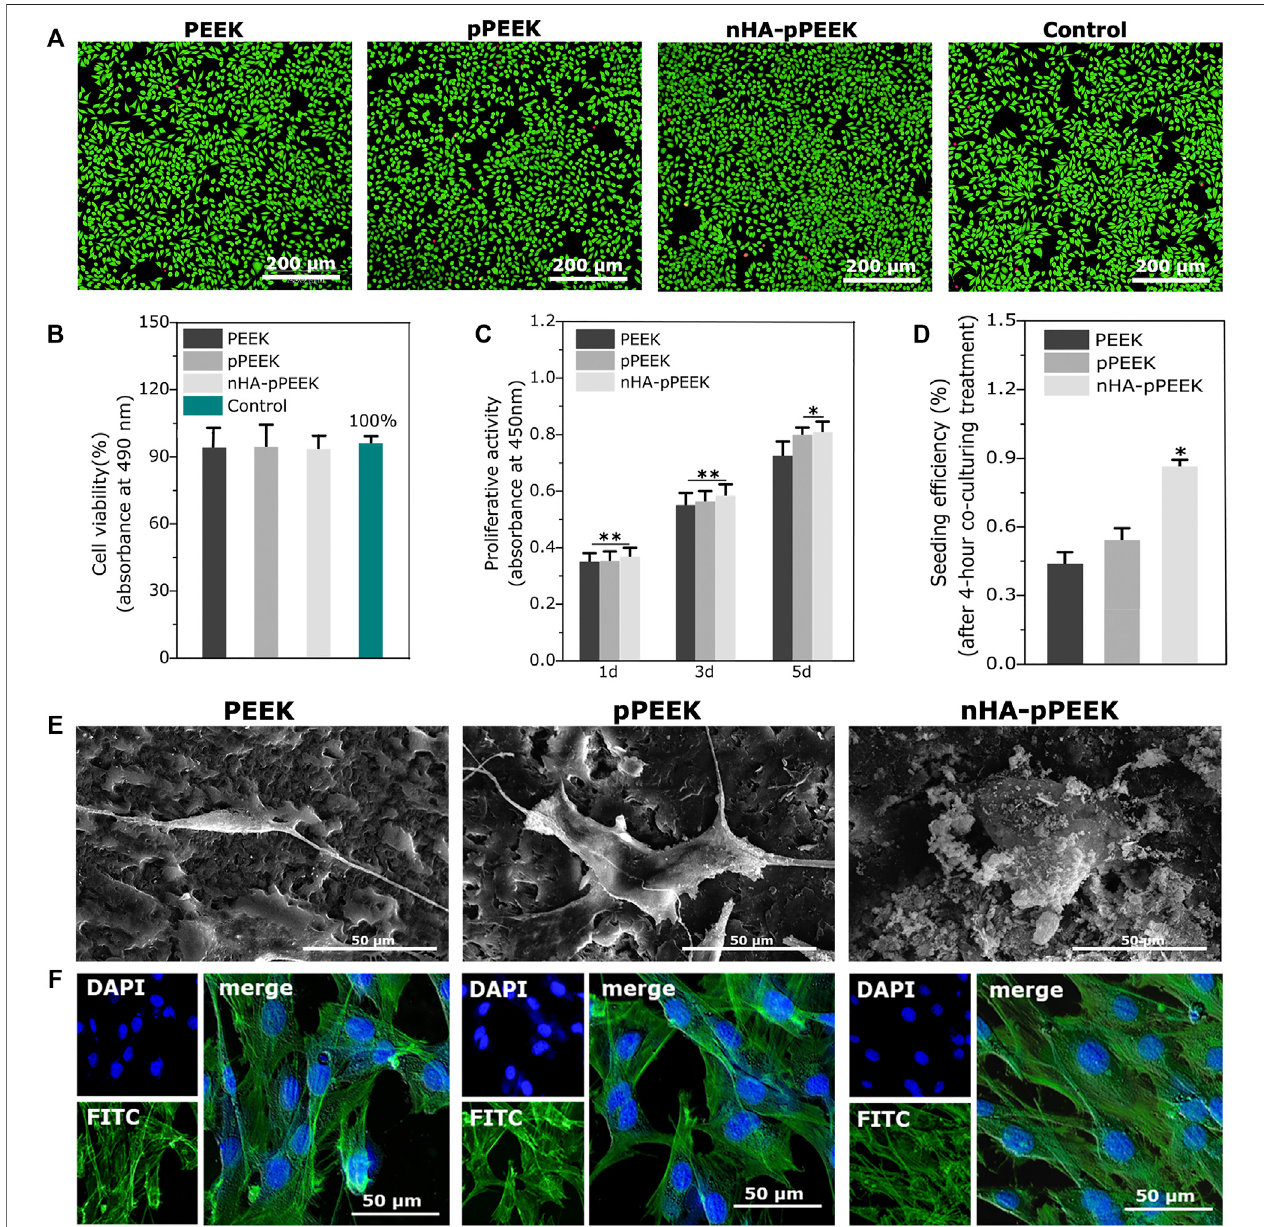
FIGURE 2 | Biocompatibility of prepared materials. (A) Live/dead cell staining for evaluation of different extracts from all groups. (B) Cell cytotoxicity quantitative measurement by the MTT assay. (C) Analysis of cell proliferation on different surfaces of all groups. (D) Seeding ef fi ciency for MC3T3-E1 cells on the different materials. (E) CellmorphologyinSEMofMC3T3-E1osteoblastcellsafterco-culturewithdifferentsamples. (F) FluorescentstainingofcellswithFITC-phalloidin(actincytoskeleton, green) and DAPI (nucleus,